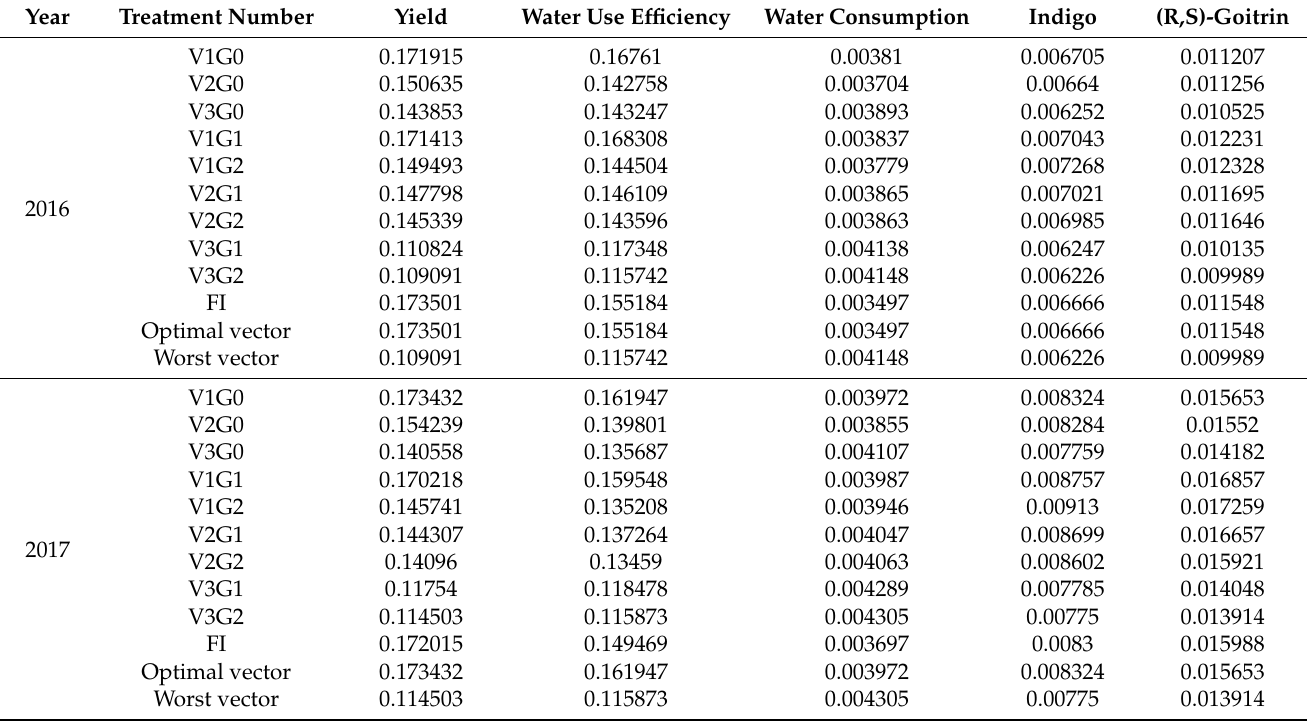
Table 8. The weighted matrix of each standardized evaluation